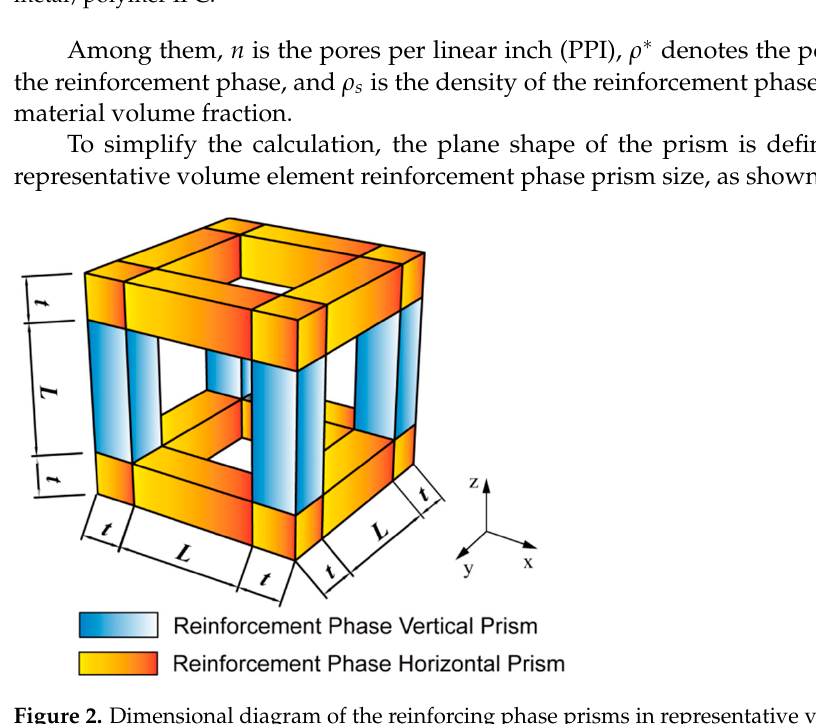
Figure 2. Dimensional diagram of the reinforcing phase prisms in representative volume elements of metal/polymer IPC.